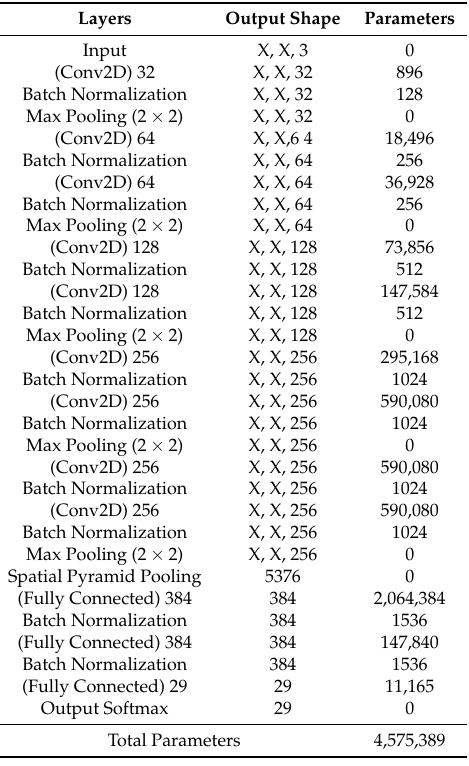
Table 2. Proposed spatial pyramid pooling in the deep convolutional network. Input (X, X) denotes any arbitrary input image dimensions. Layers Output Shape